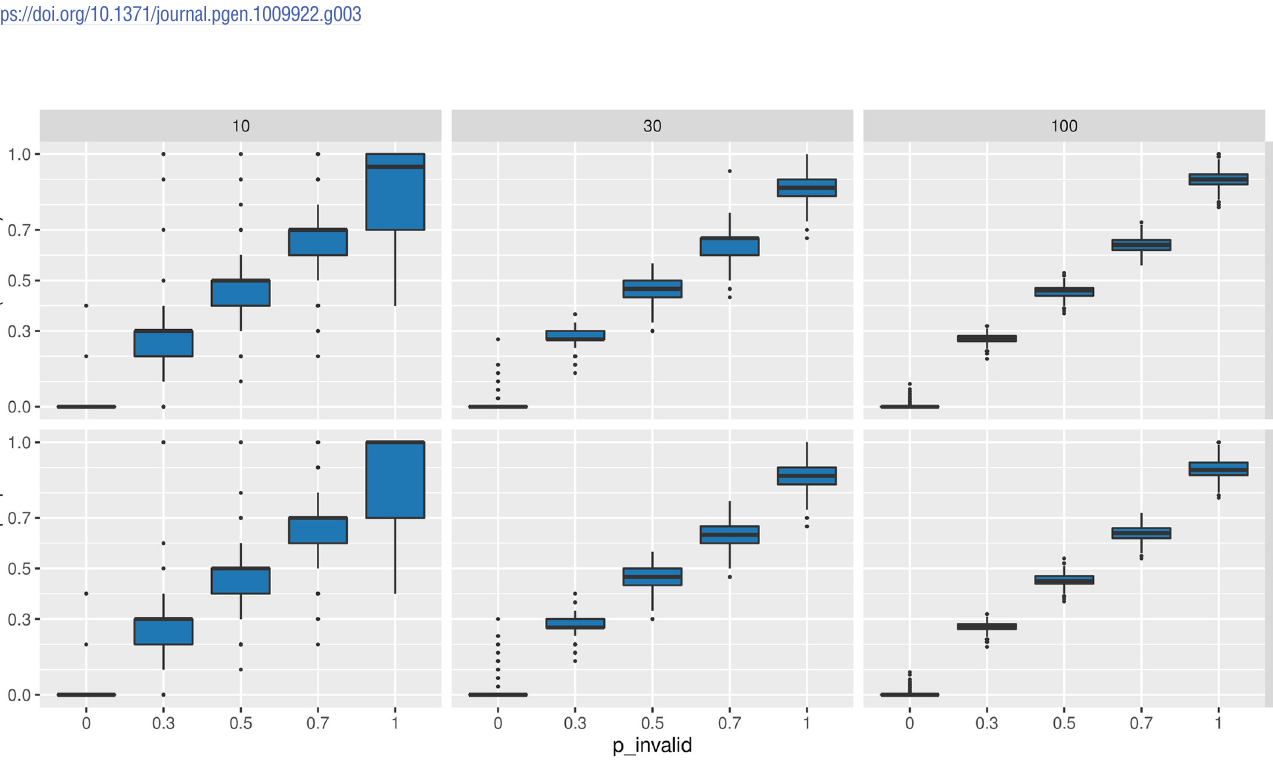
PLOS Genetics | https://doi.org/10.1371/journal.pgen.1009922 November 18,